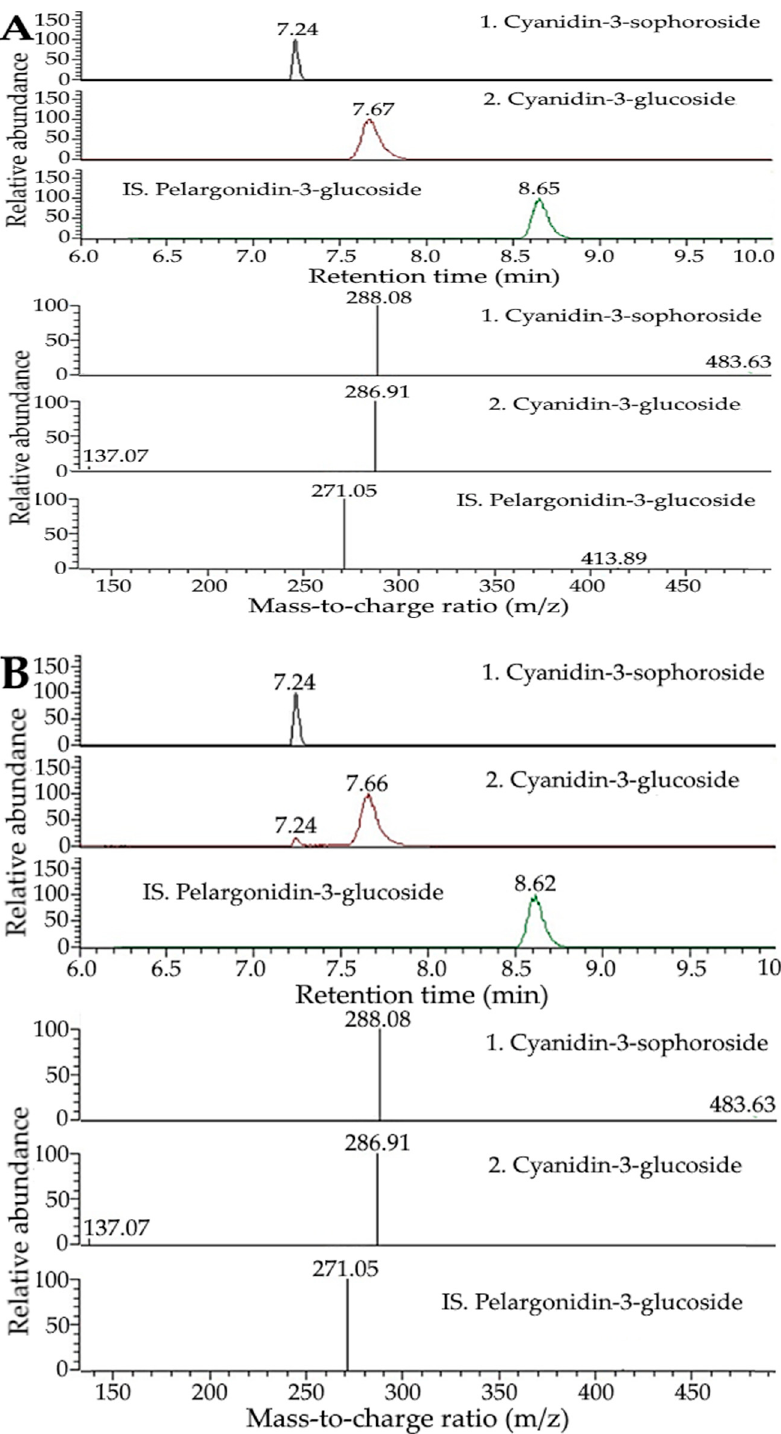
Figure 3. UPLC-MS/MS chromatograms of anthocyanin standards and internal standard perlargonidin-3-glucoside ( A ) and extract containing internal standard perlargonidin-3-glucoside ( B ) as detected by SRM mode.